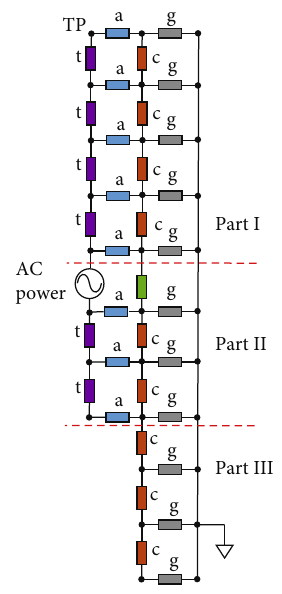
Figure 2: Equivalent resistor network of downhole pressure wireless transmission medium model.